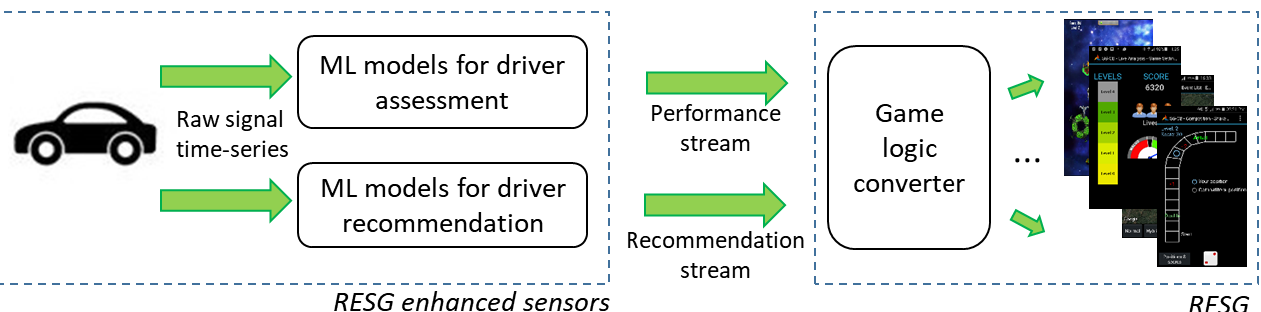
Figure 1. The driver assessment and recommendation modules process vehicular signals and provide information usable inside different types of games.